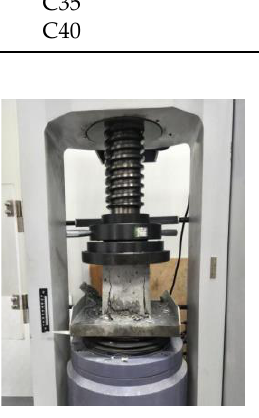
Figure 1. Compressive test for concrete. Table 1. Mixture proportion of the concrete.